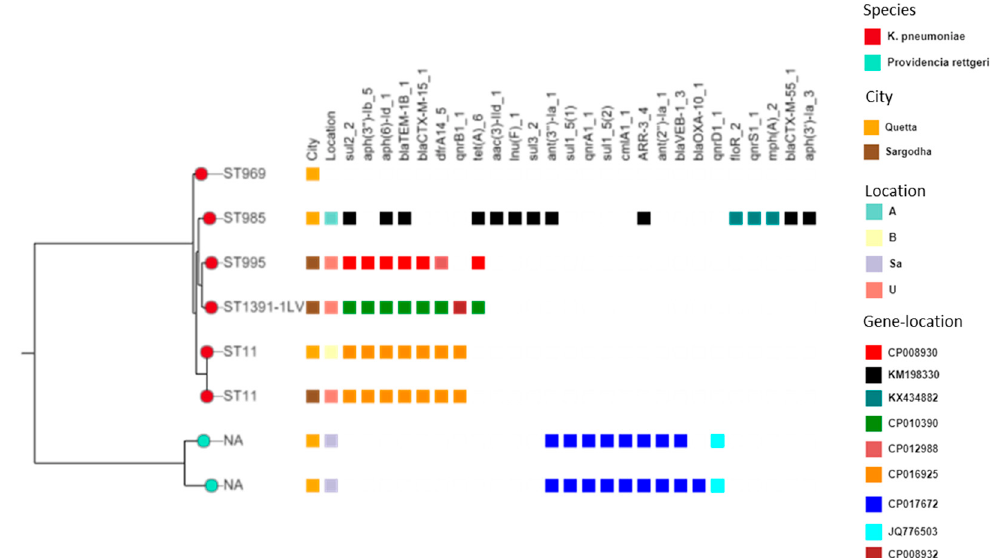
Figure 2. Approximate maximum-likelihood phylogenetic tree of the isolates carrying plasmids with linked resistance genes isolated from different dairy farms. The accession number of plasmids identified by MOB-suite (gene-location) and resistance genes identified using Abricate with the ResFinder database are shown. Only plasmids associated with linked resistance genes are included.